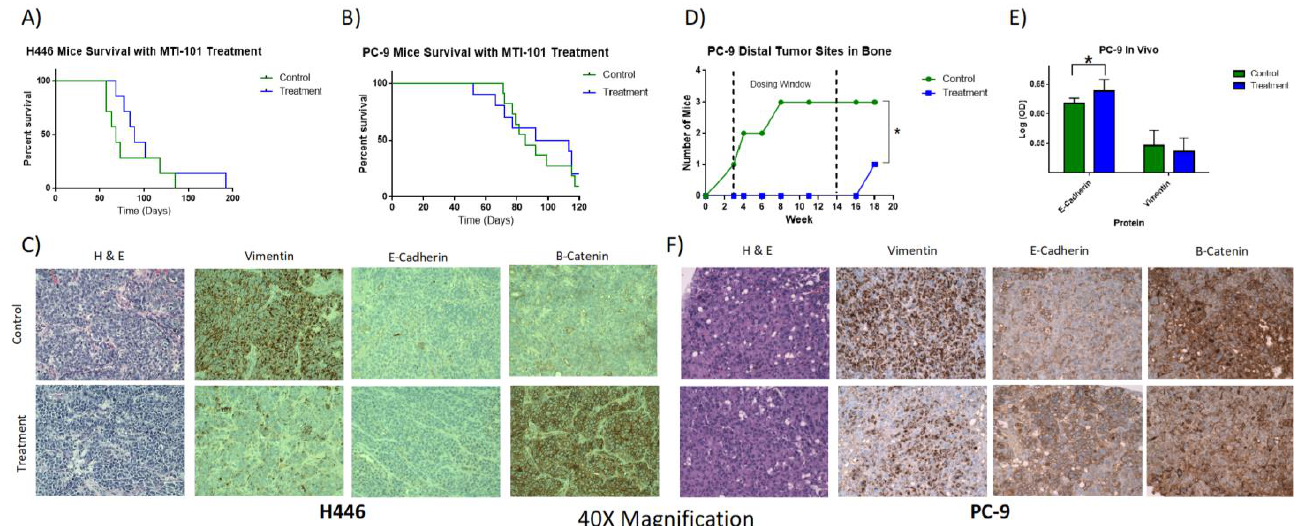
Figure 5. MTI-101 Treatment In Vivo Recapitulates the In Vitro MET Phenotype. Kidneys were taken from the H446 in vivo study, fixed in formalin, paraffin blocked and then sliced for slides to analyze EMT markers. The lungs of the PC-9 study went through the same process. Three control and three treatment (10 mg/kg MTI-101 three times per week IP injection) mice were picked at random from H446 and six of each in PC-9 were picked to compare EMT markers. ( A ) Survival curve shows no significant differences between MTI-101 treatment and control ( n = 14, p > 0.05 log rank test). ( B ) Survival curve shows no significant differences between treatment and control in PC-9 study ( n = 21, p > 0.05 log rank test). ( C ) H446 study tumor portions of the kidneys stained with H&E to confirm presence of tumor and EMT markers (vimentin, E-cadherin and β -catenin) demonstrates in vivo tumor transformation to MET with chronic treatment with 10 mg/kg of MTI-101. ( D ) PC-9 study quantity of mice detected with tumor in the bone over time course of study detected by IVIS and confirmed by H&E stains. ( E ) Quantification of E-cadherin and vimentin in IHC stains of PC-9 study ( n = 6 tissues stained from control and drug treated cohort). ( F ) PC-9 H&E and IHC stains of lungs show presence of tumor and a significant increase in E-cadherin expression but no significant change in vimentin or β -catenin between control and MTI-101 treatment. Average representative image shown for all IHC. Tumors engrafted for 4 weeks (H446) and 3 weeks (PC-9) prior to drug treatment. Error bars represent SEM (significances denoted * for p < 0.05, two-tailed T -test).